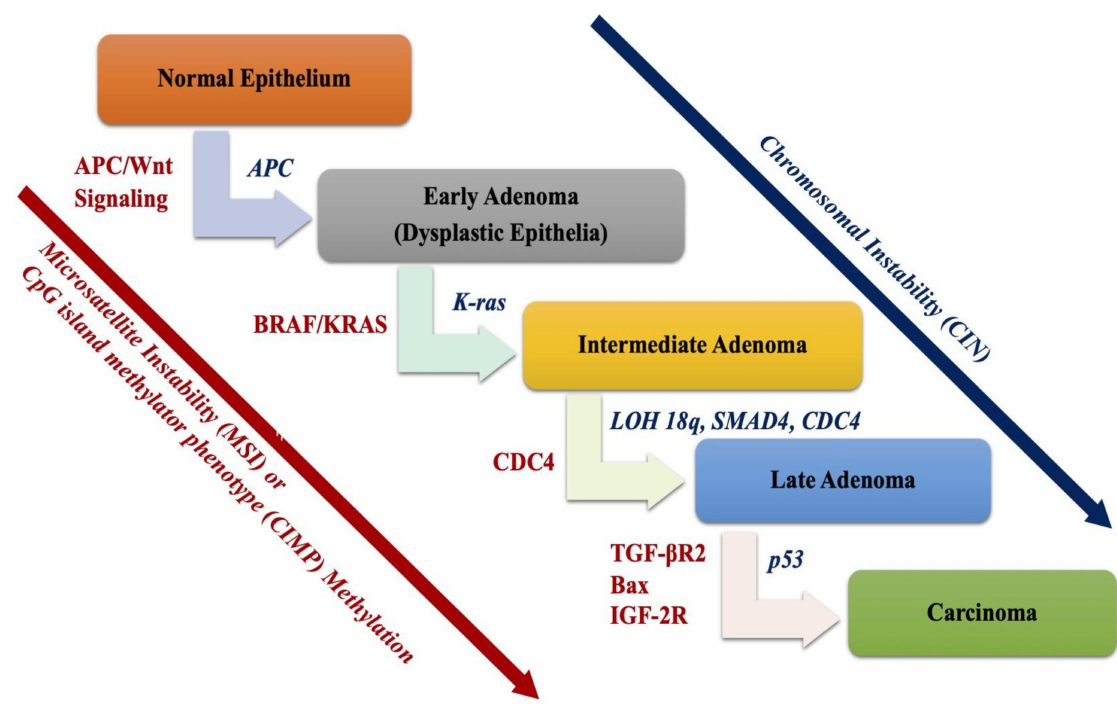
Figure 1. Multistep genetic model for colorectal adenocarcinoma sequence. There are three pathways regulating the adenocarcinoma sequence: chromosomal instability (CIN), microsatellite instability (MSI), and CpG island methylator phenotype (CIMP)